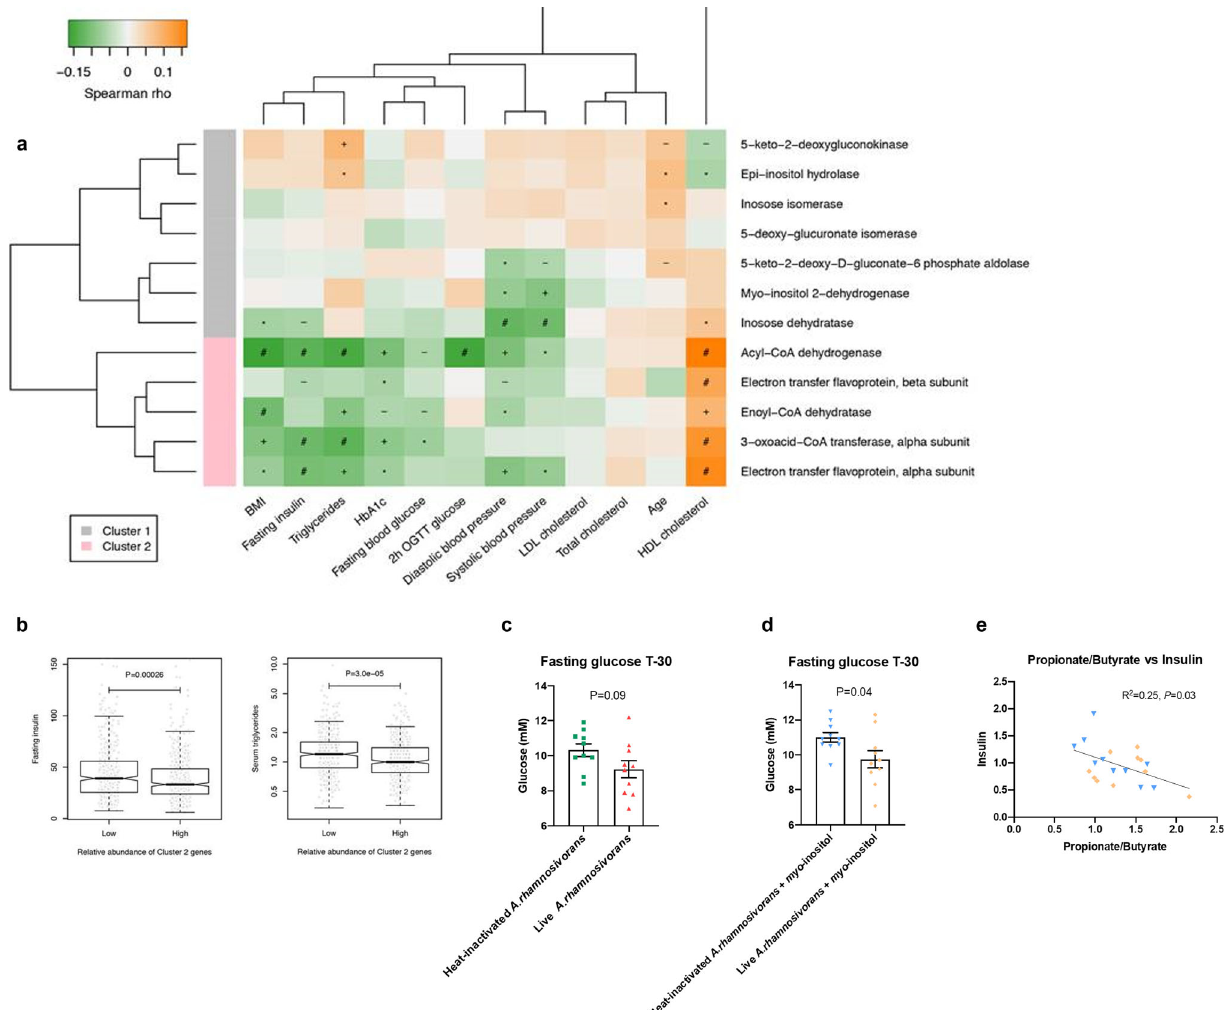
Fig. 6 Propionate production gene cluster negatively associates with metabolic risk markers in prediabetes/diabetes cohort and reduced fasting glucose in mice fed with live A. rhamnosivorans . Metagenomic analysis ( a ) shows that inositol utilisation gene cluster (cluster 1) did not form signi fi cant correlation with metabolic biomarkers while propionate production gene cluster (cluster 2) was signi fi cantly negatively associated with metabolic risk markers, especially fasting insulin and serum triglyceride (Spearman correlation); ( b ) shows signi fi cant differences in levels of fasting insulin ( P = 2.6e-04) and serum triglyceride ( P = 3.0e-05) in individuals with low versus high abundances of cluster 2 genes in a Swedish prediabetes cohort (Wilcox rank-sum test). − P < 0.1; * P < 0.05; + P < 0.01; # P < 0.001. The horizontal line in each box represents the median, the top and bottom of the box the 25th and 75th percentiles, and the whiskers 1.5 times the interquartile range. Fasting glucose levels in western diet fed C57BL/6J mice after 6 weeks oral administration of heat-killed or live A. rhamnosivorans without ( c ) or with myo -inositol ( d ). N = 10 mice per group. Data are mean ± SEM; statistical analysis was done by unpaired two-tailed Student ’ s t tests. Pearson correlation ( e ) between caecal propionate:butyrate ratio and fasting insulin in mice treated with heat-killed (blue circles) or live (orange circles) A. rhamnosivorans plus myo -inositol ( P =